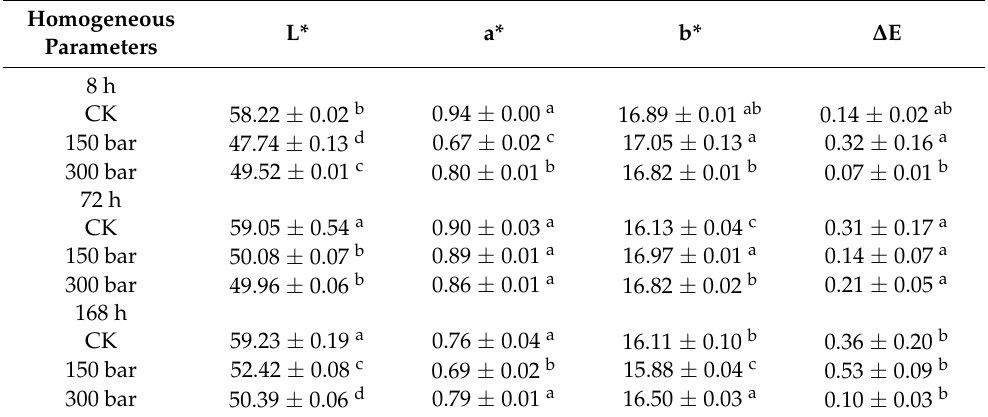
Table 4. Effect of different homogenization pressures on milk chromaticity at each treatment time. Homogeneous L* a* b* ∆ Parameters